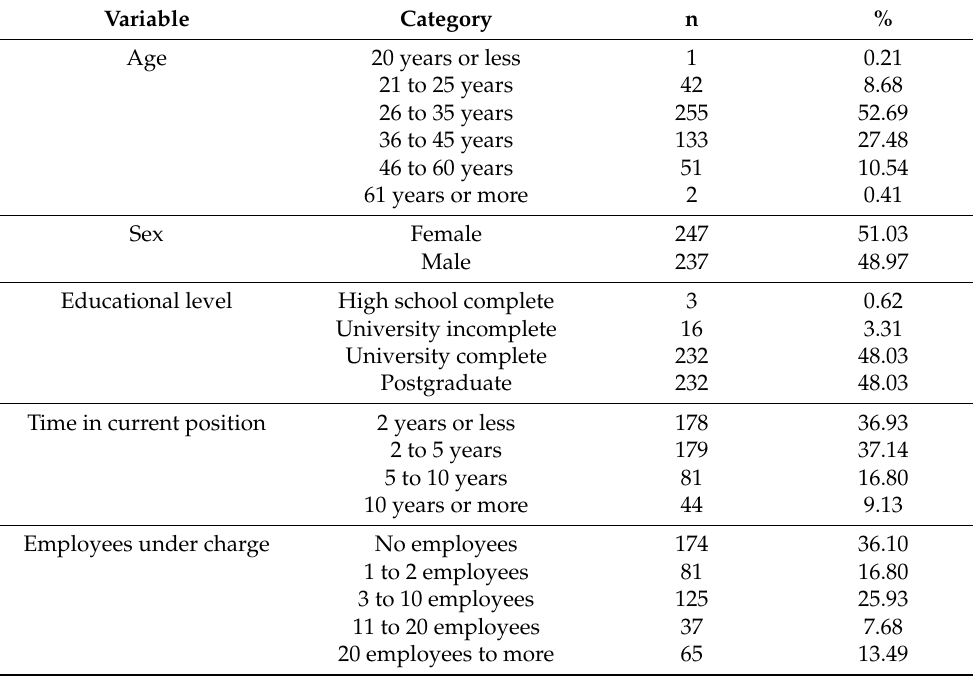
Table 1. Sociodemographic characteristics of